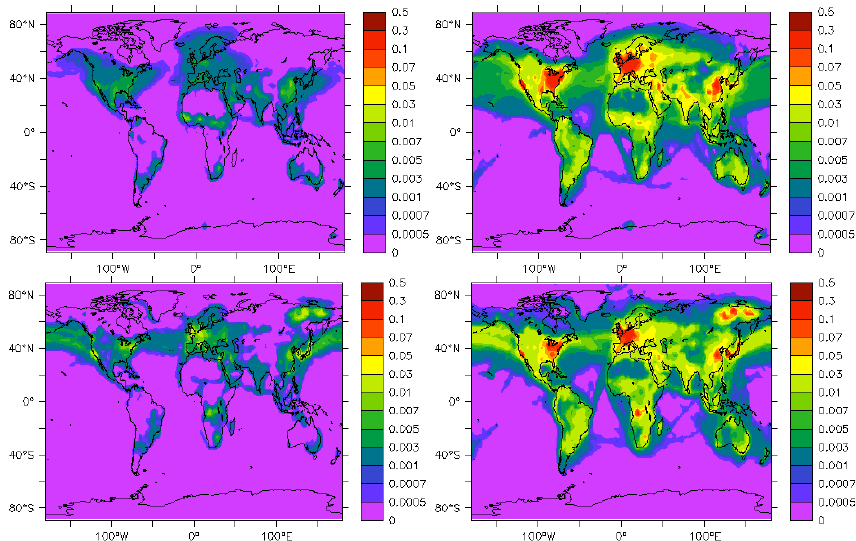
Fig. 1. Simulated monthly average HONO mixing ratios (ppbv) from the reference run (base_S1, left) and the sensitivity run (S1, i.e. using a HONO/NO x ratio of 0.02, right) near the surface in January (upper panels) and July (lower